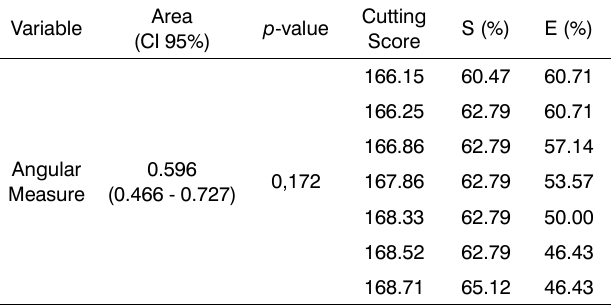
Table 4 . Área sob a curva ROC, valores de corte e respectivos valores de sensibilidade e especificidade da medida angular para os GC e GDM.